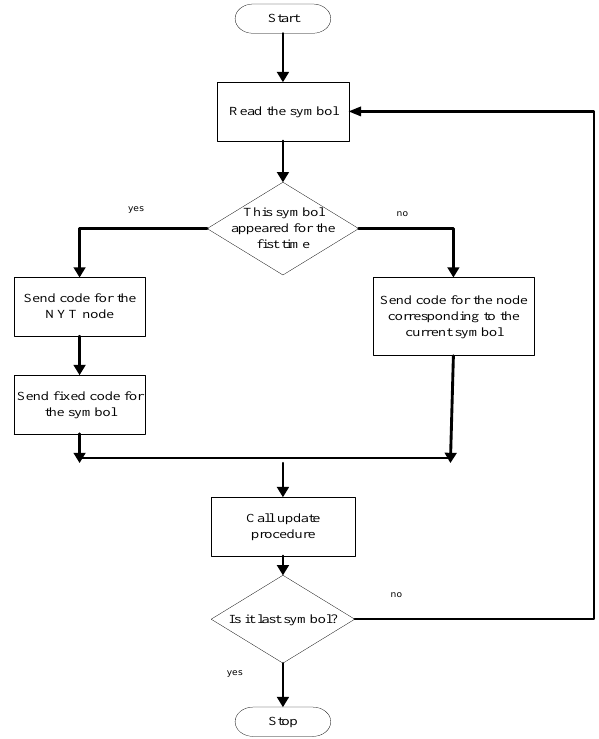
Figure 6. Adaptive Huffman encoding